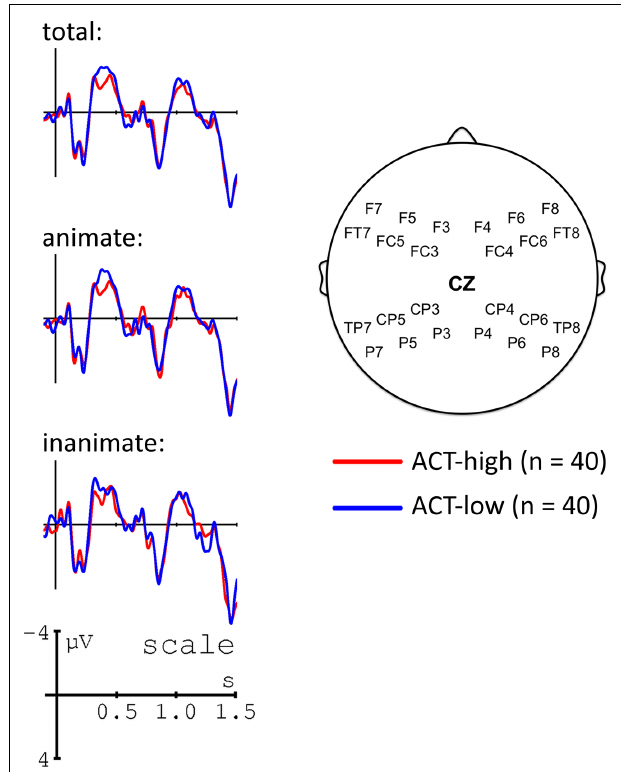
FIGURE 9 | Grand-average ERPs at the position of NP2 in object-initial sentences (onset at the vertical bar) at electrode FC3. The figure contrasts high ACT (red trace) and low ACT (blue trace) nouns for animate and inanimate nouns, respectively. Negativity is plotted